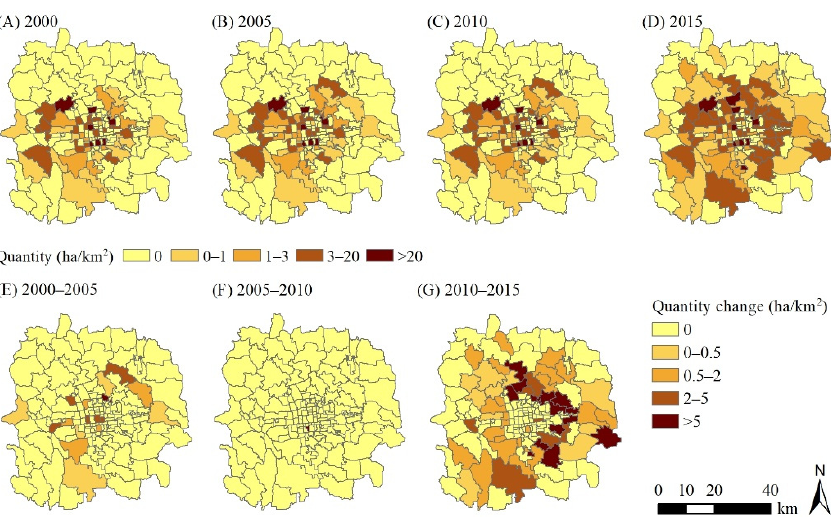
Figure 3. Urban park accessibility in quantity characteristic from 2000 to 2015. ( A – D ) represented the distribution pattern of urban park quantity in 2000, 2005, 2010 and 2015, respectively and ( E – G ) represented the change in urban park quantity from 2000–2005, 2005–2010 and 2010–2015, respec-